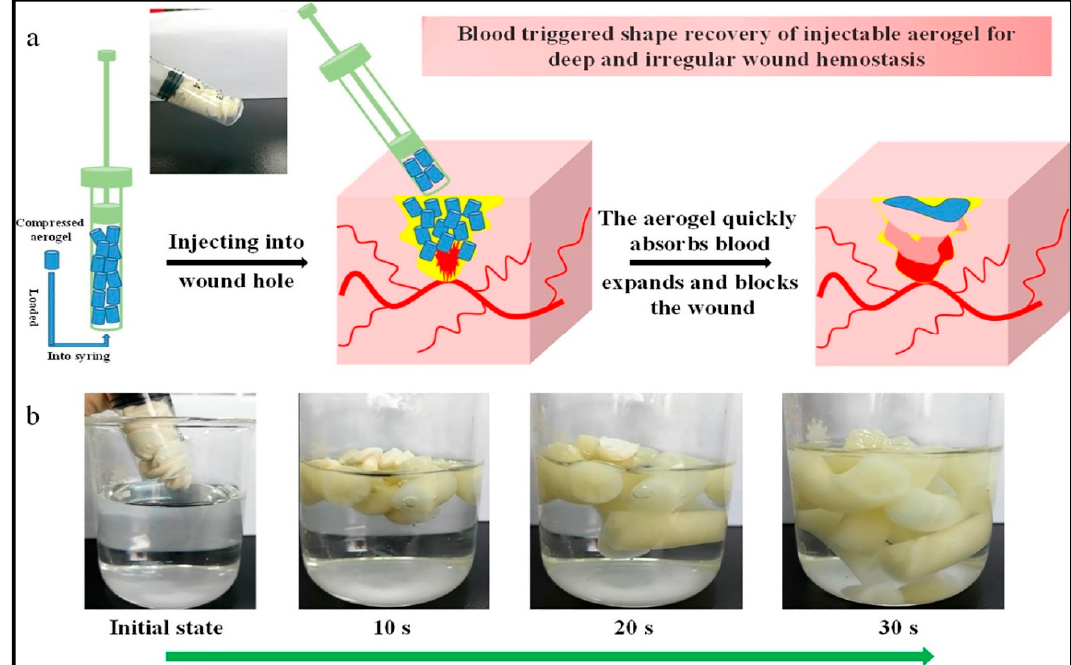
Figure 8. ( a ) Schematic illustration of simulating injection aerogel composites into the wound, ( b ) digital photos of aerogel with rapid shape recovery after water absorption. Adapted from Fan et al. [157].